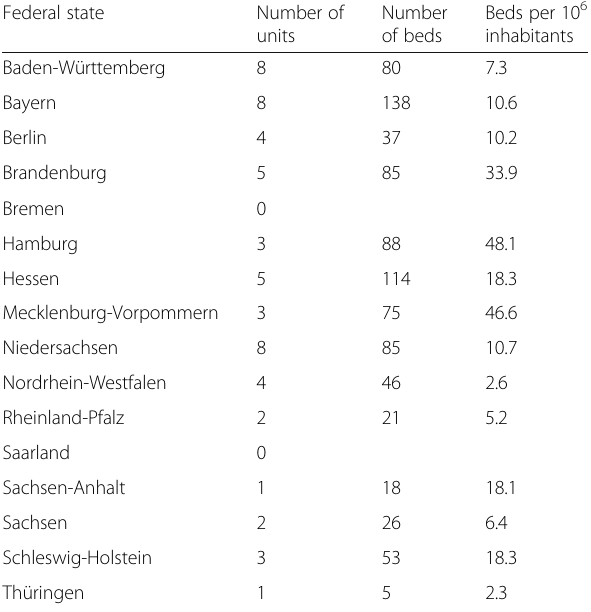
Table 1 Distribution of reported hospital capacities for combined prolonged weaning and neurorehabilitation